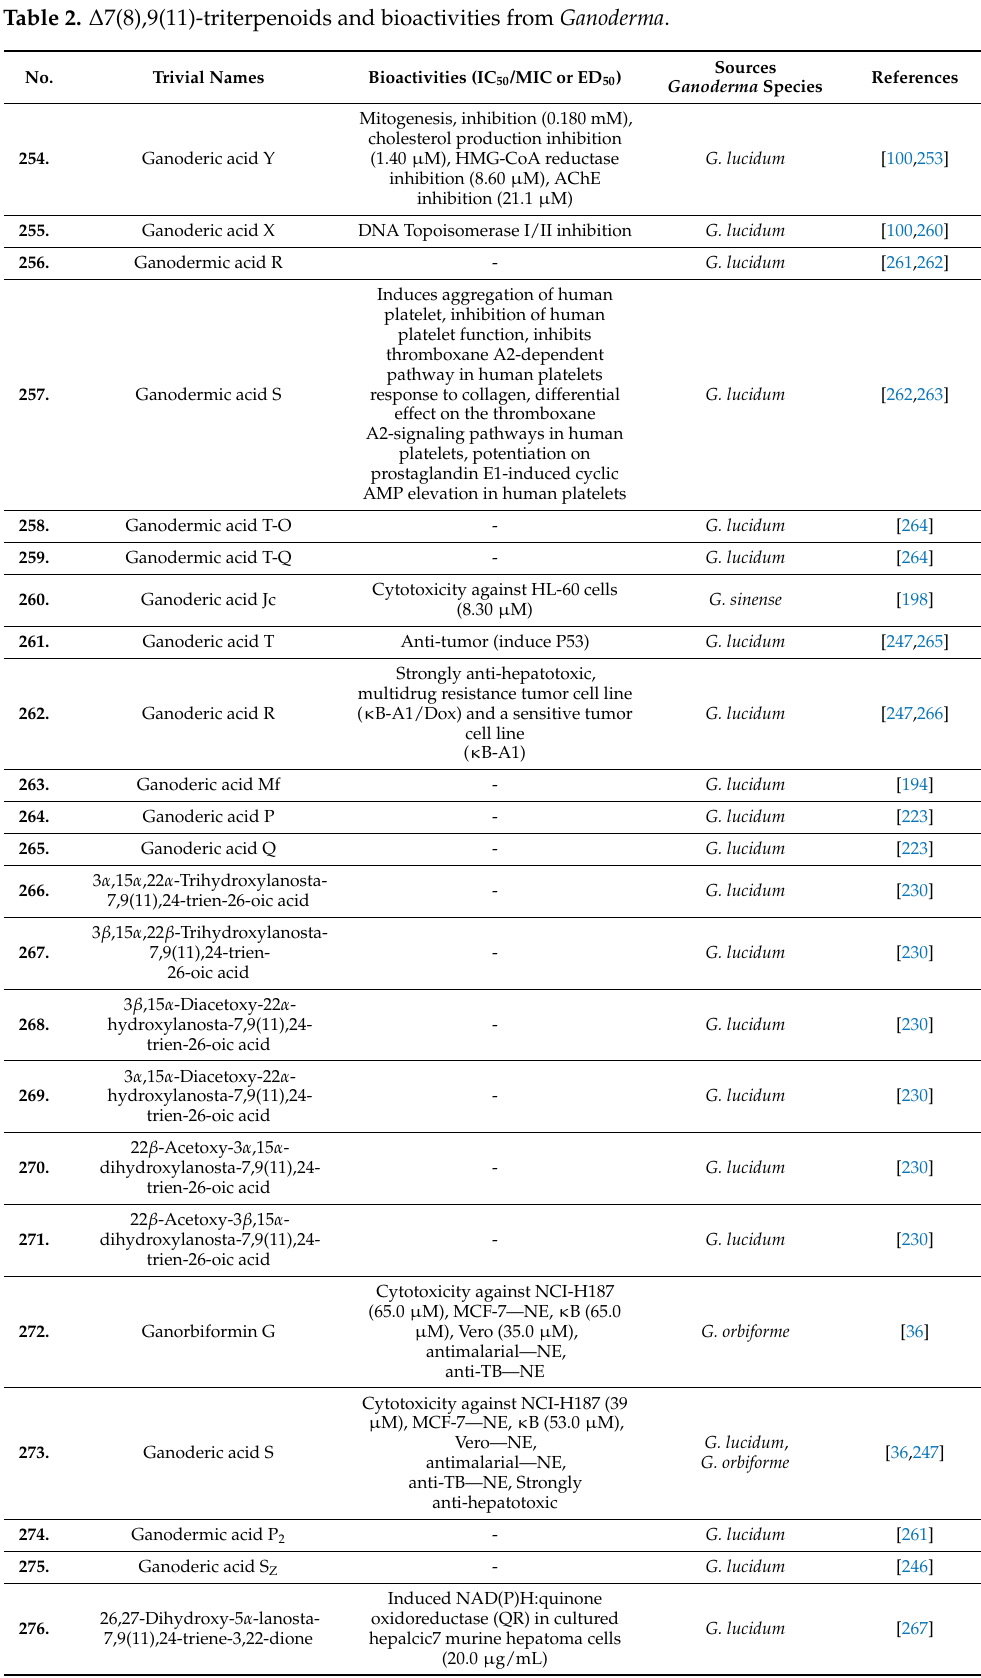
Table 2. ∆ 7(8),9(11)-triterpenoids and bioactivities from Ganoderma